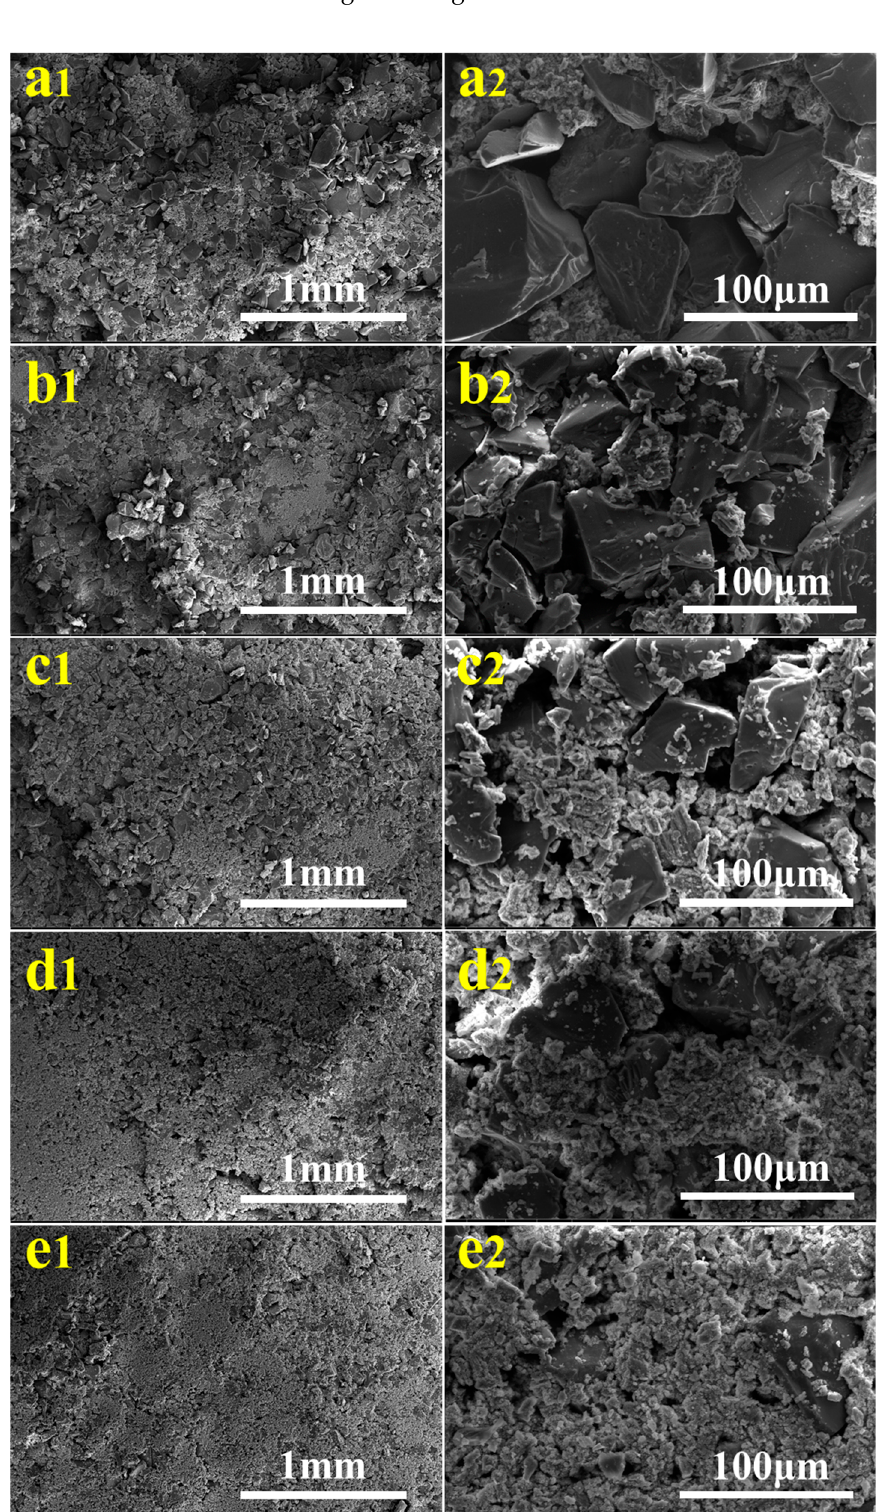
Figure 4. SEM patterns of specimens: ( a ) TQSC-100%; ( b ) TQSC-90%; ( c ) TQSC-80%; ( d ) TQSC-70% and ( e ) TQSC-60%.